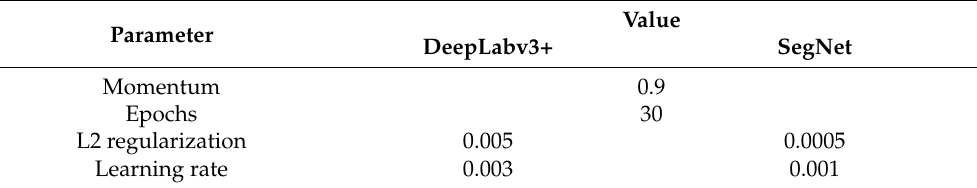
Table 1. Hyperparameters set for this